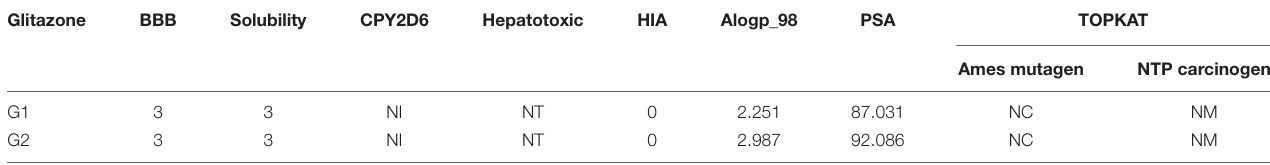
TABLE 2 | In sillco ADME properties and TOPKAT toxicity model analysis of novel glitazones. Glitazone